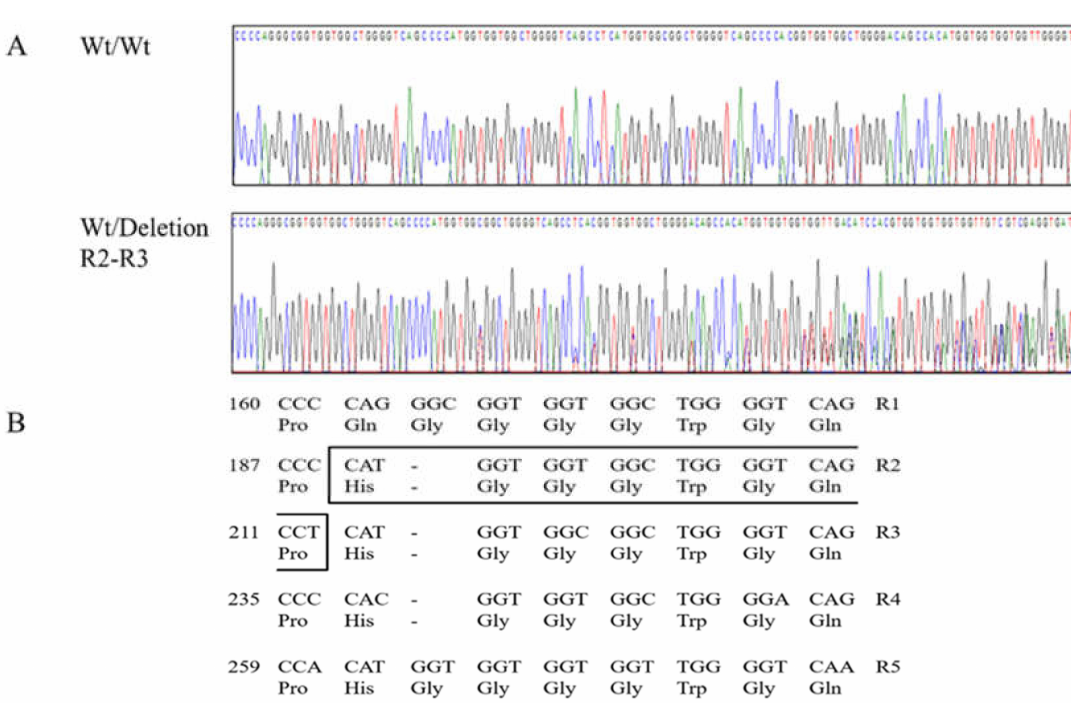
Figure 3. Electropherograms of novel insertion / deletion polymorphism of the canine prion protein ( PRNP ) gene. ( A ) Electropherograms showing the polymorphism at the octapeptide repeat region. Upperportion: insertion / insertionhomozygoteofthecanine PRNP andlowerportion: insertion / deletion heterozygote of the canine PRNP . ( B ) The amino acid and nucleotide sequences of the repeat region of the canine PRNP gene. The box indicates the 64_71del HGGGWGQP polymorphism which was found between R2 and R3. R1: octapeptide repeat 1 (54Pro, 55Gln, 56Gly, 57Gly, 58Gly, 59Gly, 60Trp, 61Gly, 62Gln); R2: octapeptide repeat 2 (63Pro, 64His, 65Gly, 66Gly, 67Gly, 68Trp, 69Gly, 70Gln); R3: